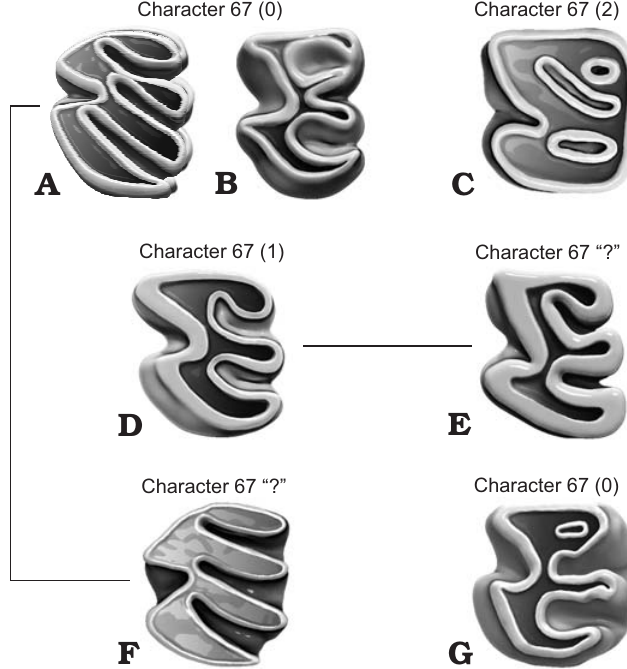
Fig. 2. Character state coding of character 67 of Verzi et al. (2014), “Mesolophid of m1–2 or the corresponding spur” as scored by these au- thors for several octodontoid taxa. A . Myocastor , scored as 67-0 (i.e., present, at least during early ontogenetic stages). B . Acaremys (including Sciamys ), scored as 67-0 (i.e., present, at least during early ontogenetic stages). C . Proechimys , scored as 67 [02], showing a specimen correspond- ing to character state 67-2 (i.e., fused to metalophulid II forming a com- plex crest). D . Neophanomys , scored as 67-1 (i.e., absent). E . Thrichomys , scored as “?”. F . The tetralophodont Spaniomys , scored as “?”. G . Sciamys , showing persistence of transverse lophids in an adult specimen (MLP 15- 218). Vertical and horizontal lines indicate essentially the same occlusal patterns that were differently